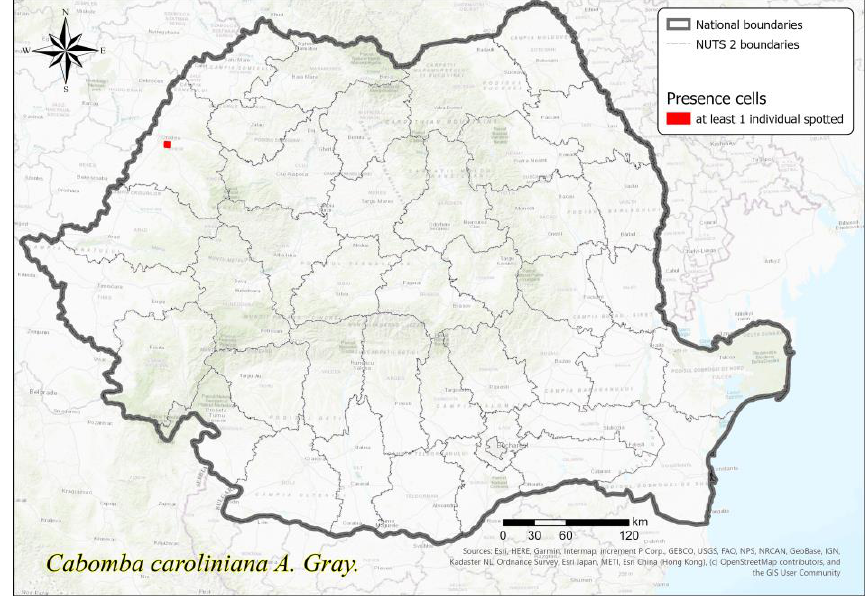
Fig. 3. Cabomba caroliniana , as well as Myriophyllum aquaticum , are reported from only